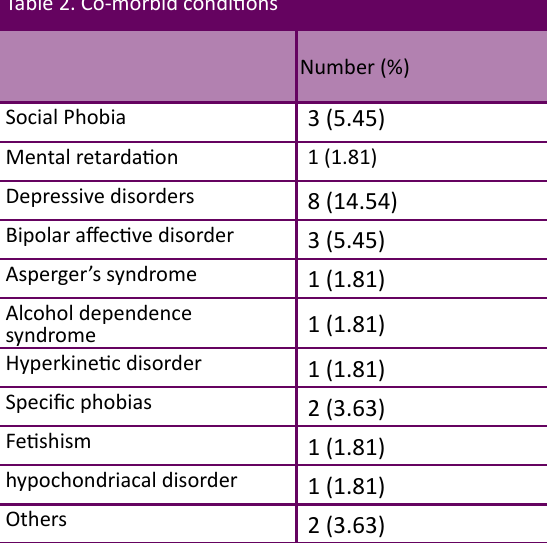
Table 2. Co-morbid